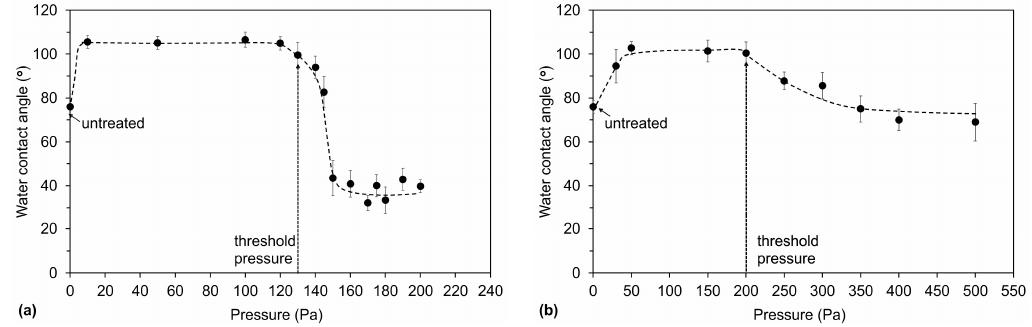
Figure 6. Water contact angles for the samples treated in: ( a ) SF 6 plasma and ( b ) CF 4 plasma at various pressures.